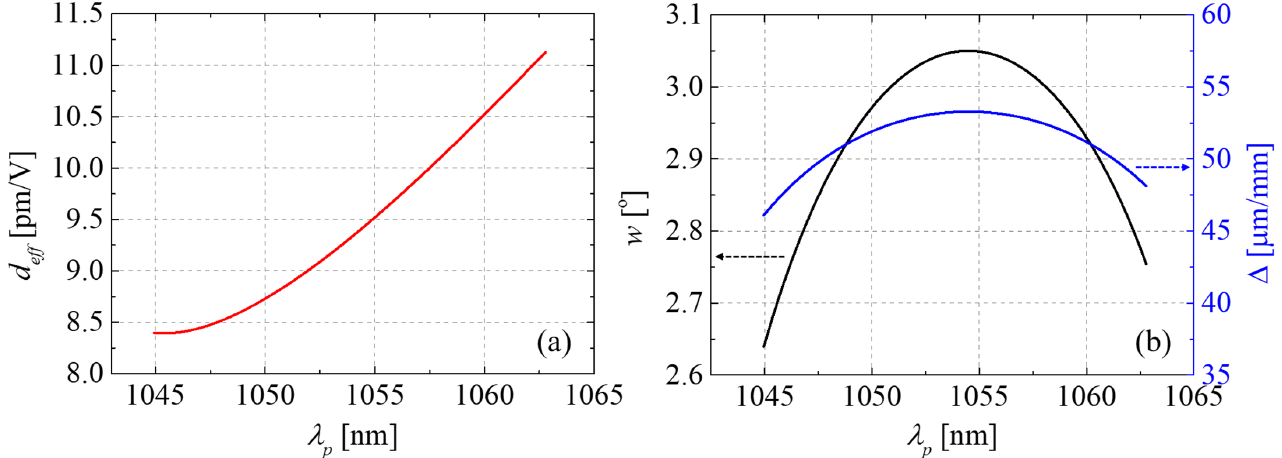
Figure 3. ( a ) The effective nonlinear optic coefficient ( d eff ); ( b ) the spatial walk-off angle ( w ) between the interacting beams, and the beam deviation ( Δ ). The numerical simulation results were plotted as functions of λ p satisfying the Type II EPM.